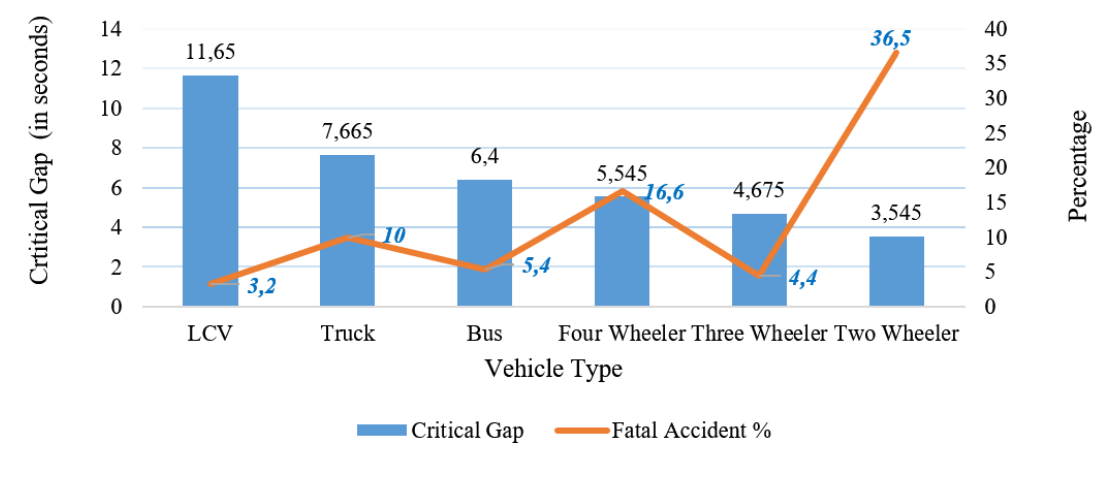
Figure 6: Percentage of accidents for different road intersections